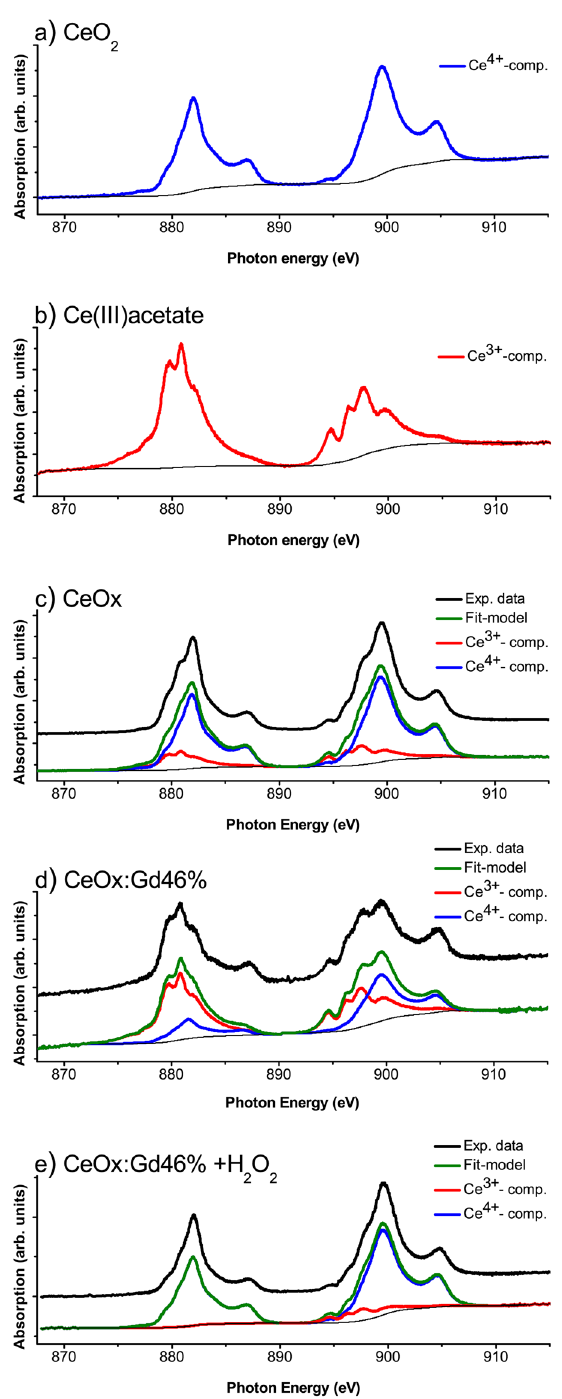
Figure 6. NEXAFS spectrum of ( a ) CeO 2 nanopowder (reference), ( b ) Ce(III)acetate (reference), ( c ) CeOx, ( d ) CeOx:Gd46% and ( e ) CeOx:Gd46% treated with 10 mM hydrogen peroxide. The spectrum component analysis was performed using